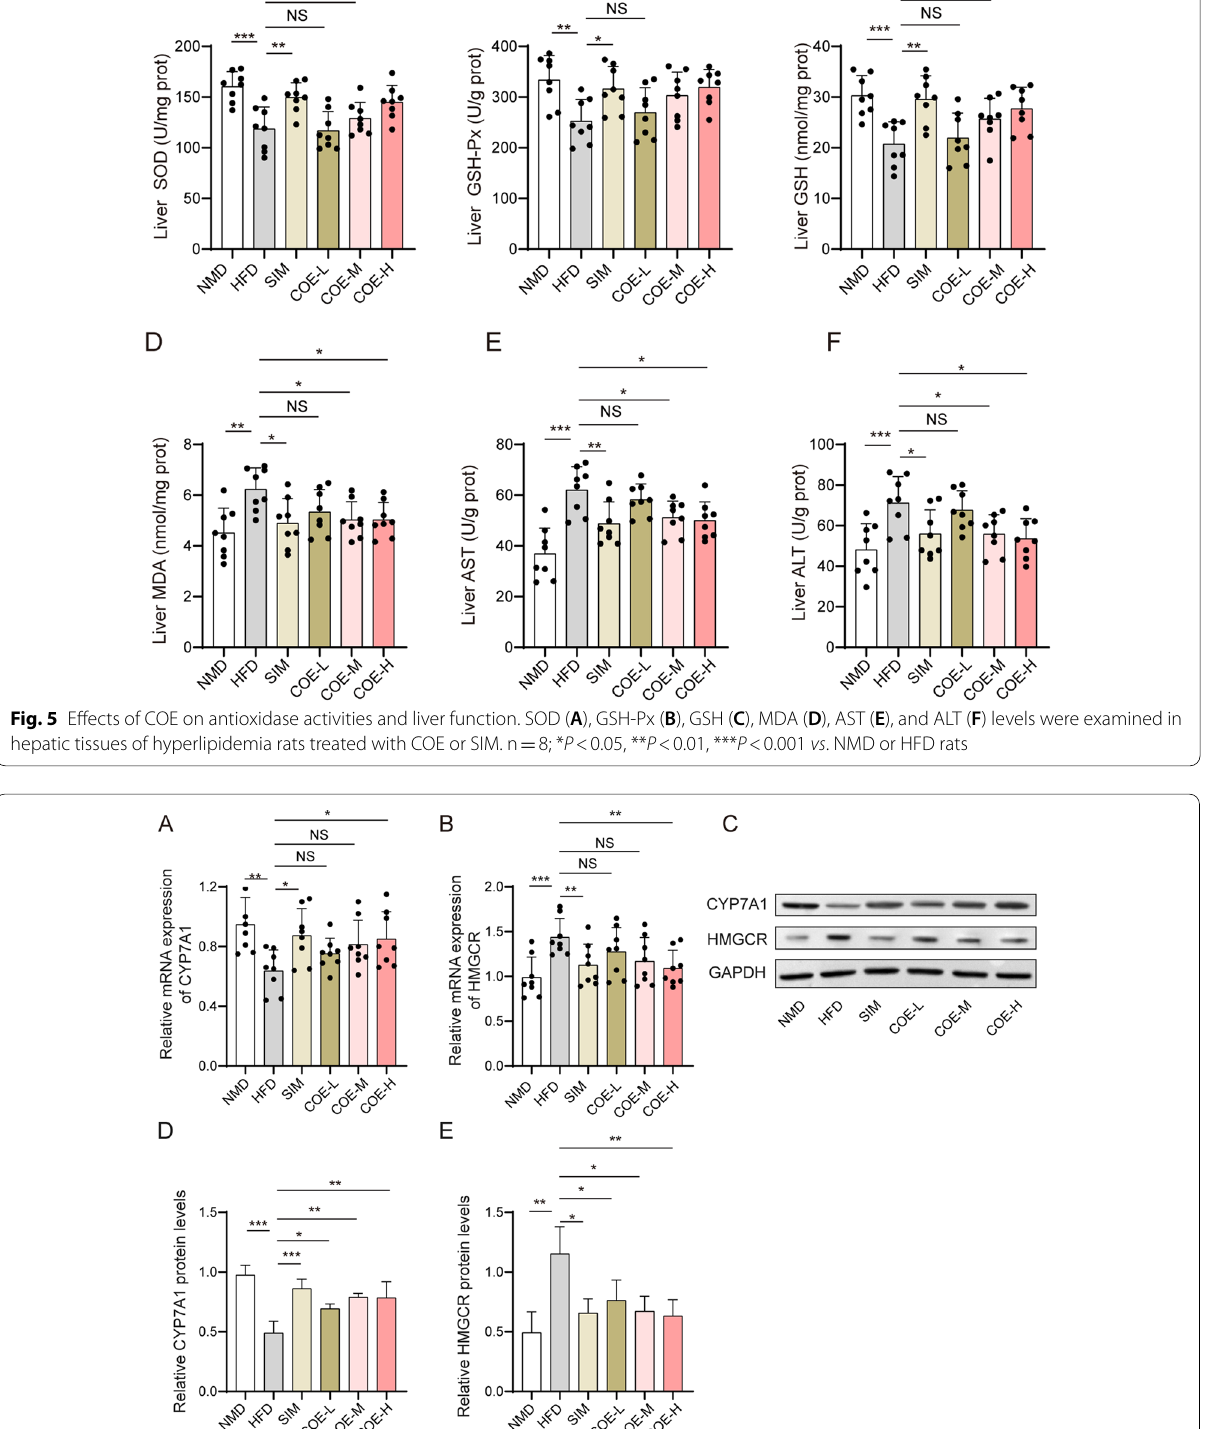
8; * P < 0.05, ** P < 0.01, *** P < 0.001 vs . NMD or HFD =